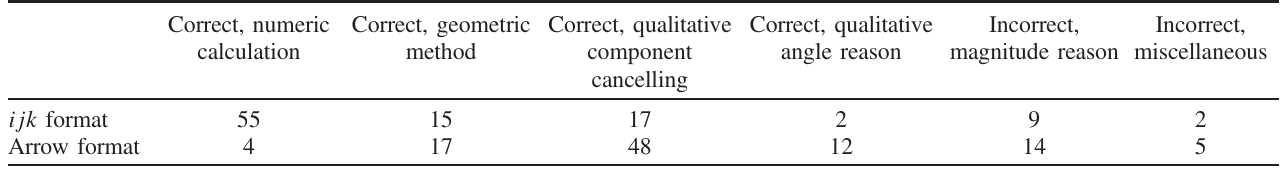
TABLE II. Percentage of students using various solution methods for the physical context vector addition question (Fig. 11) for both the arrow and ijk